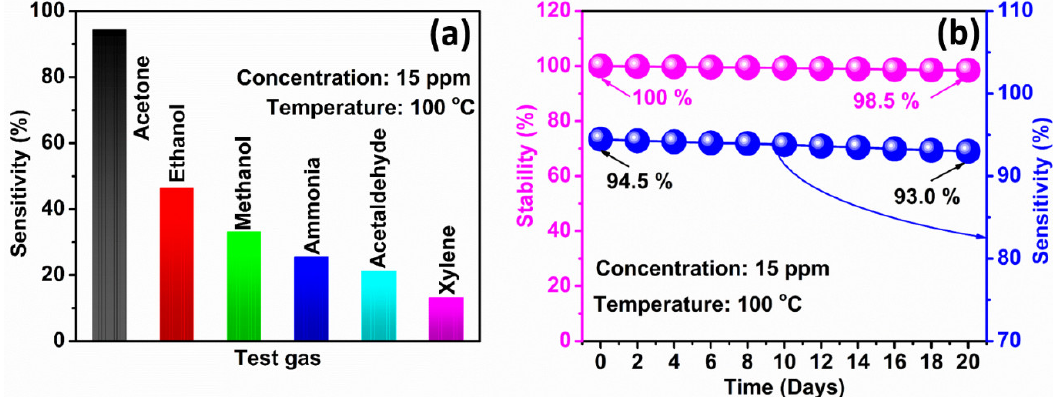
Figure 7. ( a ) Selectivity and ( b ) stability and corresponding sensitivity of the WS 2 nanorod